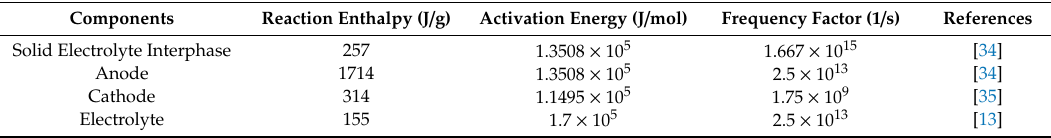
Table 3. Kinetic parameters of thermal decomposition reaction of lithium-ion battery fundamental components. The work is focused on lithium-ion battery with lithium cobalt oxide cathode and carbon